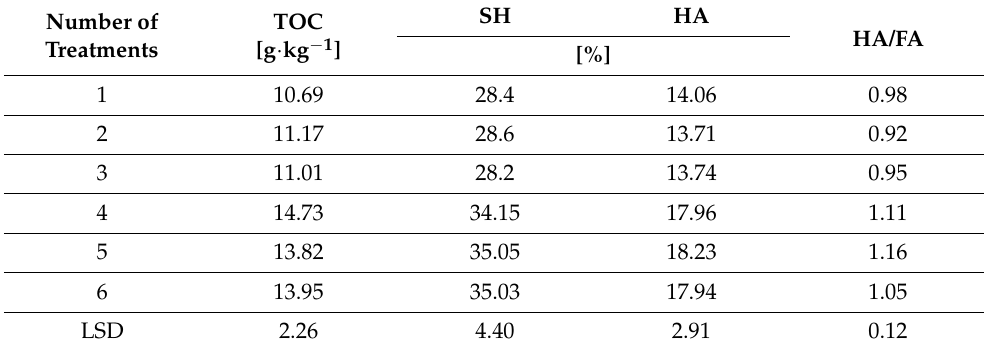
Table 2. HS in the studied